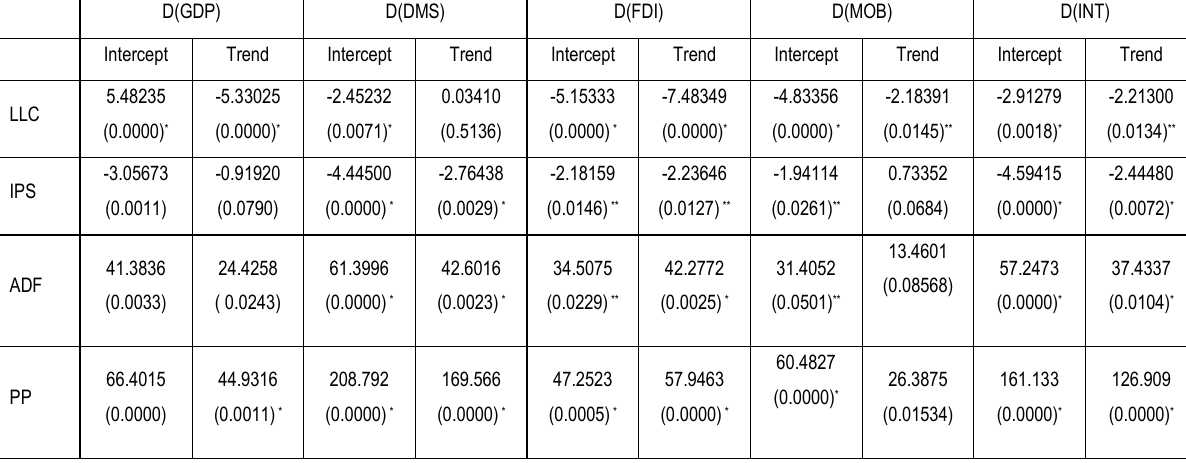
Table 3. Panel unit root tests results: series in first difference